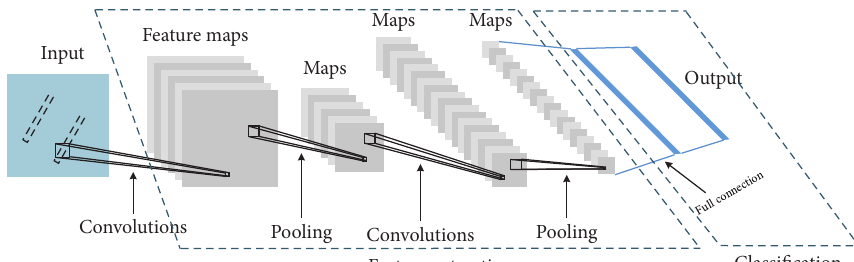
Figure 1: Structure diagram of